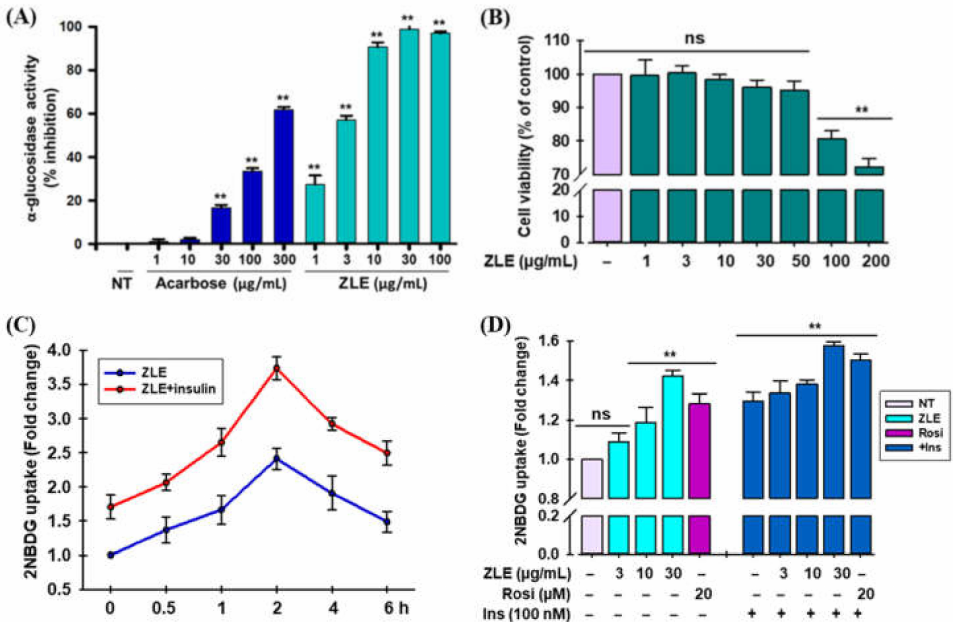
Figure 4. ( A ) α -Glucosidase inhibition activity of ethanol extracts of M. zapota leaves (ZLE). Acarbose as positive control was used in the assay. ( B ) Cell viability in C2C12 myotubes. C2C12 cells were seeded in a 96-well plate (density 1 × 10 5 cells/well) and carried out 3-(4,5-dimethylthiazol-2-yl)- 2,5-diphenyltetrazolium bromide (MTT) assay as referred to in Materials and Methods. ( C ) Time- dependent uptake of glucose by C2C12 myotubes. Cells treated with ZLE (30 µ g/mL) alone or ZLE (30 µ g/mL) along with insulin (100 nM) were incubated for the time periods indicated. ( D ) Effects of ZLE on the uptake of glucose in C2C12 myotubes. Cells were incubated with ZLE alone and/or with insulin for 2 h. Rosiglitazone (20 µ M) was employed as a positive control. (‘ns’ indicated non- significant; ‘–‘ indicated sample was not added and ‘+’ indicated sample was added). Results were as mean ± standard deviation of three analyses (** p < 0.05 versus control using one-way